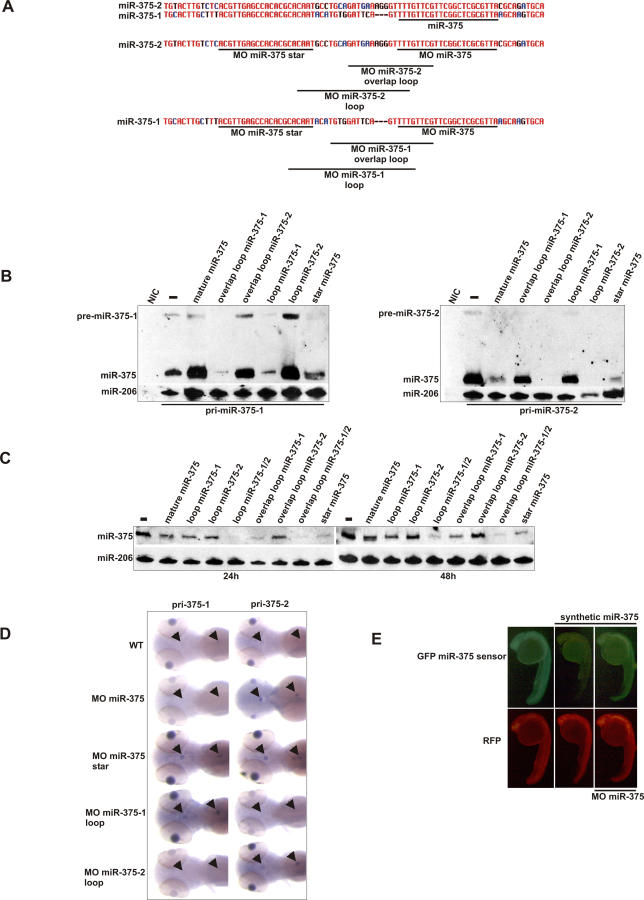
Specific Morpholinos Deplete the Embryo of miR-375(A) Sequence alignment of the two miR-375 genes from zebrafish and design of morpholinos targeting the dre-miR-375–1 and dre-miR-375–2 precursors.(B) Northern blot analysis of the effect of morpholinos on the expression of miR-375 derived from injected pri-miRNA mRNAs for miR-375–1 and miR-375–2. MO-375–1 overlap loop and loop morpholinos target exclusively the pri-miR-375–1 construct, and MO-375–2 overlap loop and loop morpholinos target exclusively the pri-miR-375–2 construct. Co-injected miR-206 serves as a loading and injection control. Embryos were collected 8 h after injection.(C) Northern blot analysis of the effect of morpholinos on endogenous miR-375 expression at 24 hpf and 48 hpf. MiR-206 serves as loading control.(D) In situ hybridization for pri-miR-375–1 and pri-miR-375–2 on wild-type (WT) and morpholino-injected embryos. Arrowheads indicate the pituitary gland and the pancreatic islet.(E) Analysis of GFP expression in 24-h embryos injected with a miR-375 GFP sensor construct, a synthetic miR-375 duplex and MO miR-375. Red fluorescent protein (RFP) serves as an injection control.NIC, noninjected control.